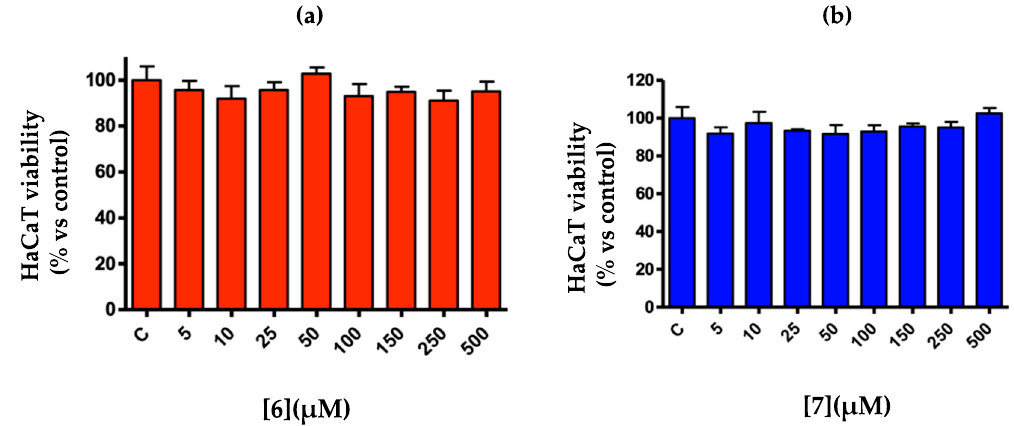
Figure 2. 3-(4,5-Dimethylthiazol-2-yl)-2,5-diphenyltetrazolium bromide (MTT) test about the cell viability of the aneuploid immortal keratinocyte c ell line after exposure to product 6 ( a ) and product 7 ( b ). The values were expressed as a percentage with respect to the control (C = 100%) to the vehicle alone and reported as mean ± SEM.